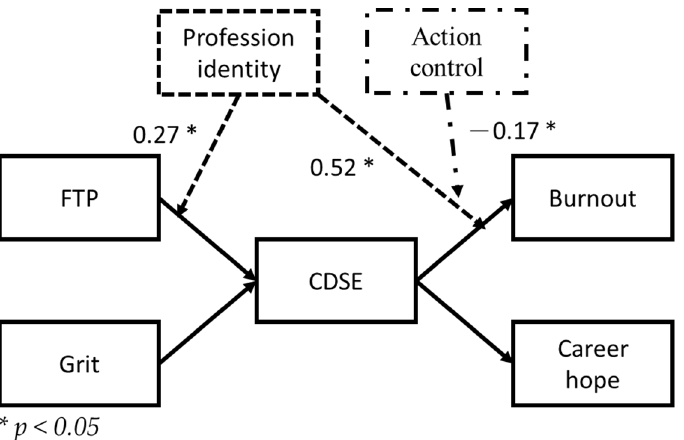
Figure 3. Path diagram of results of analysis of the moderation effects (only significant unstandard- ized solutions for the moderation effects are included).